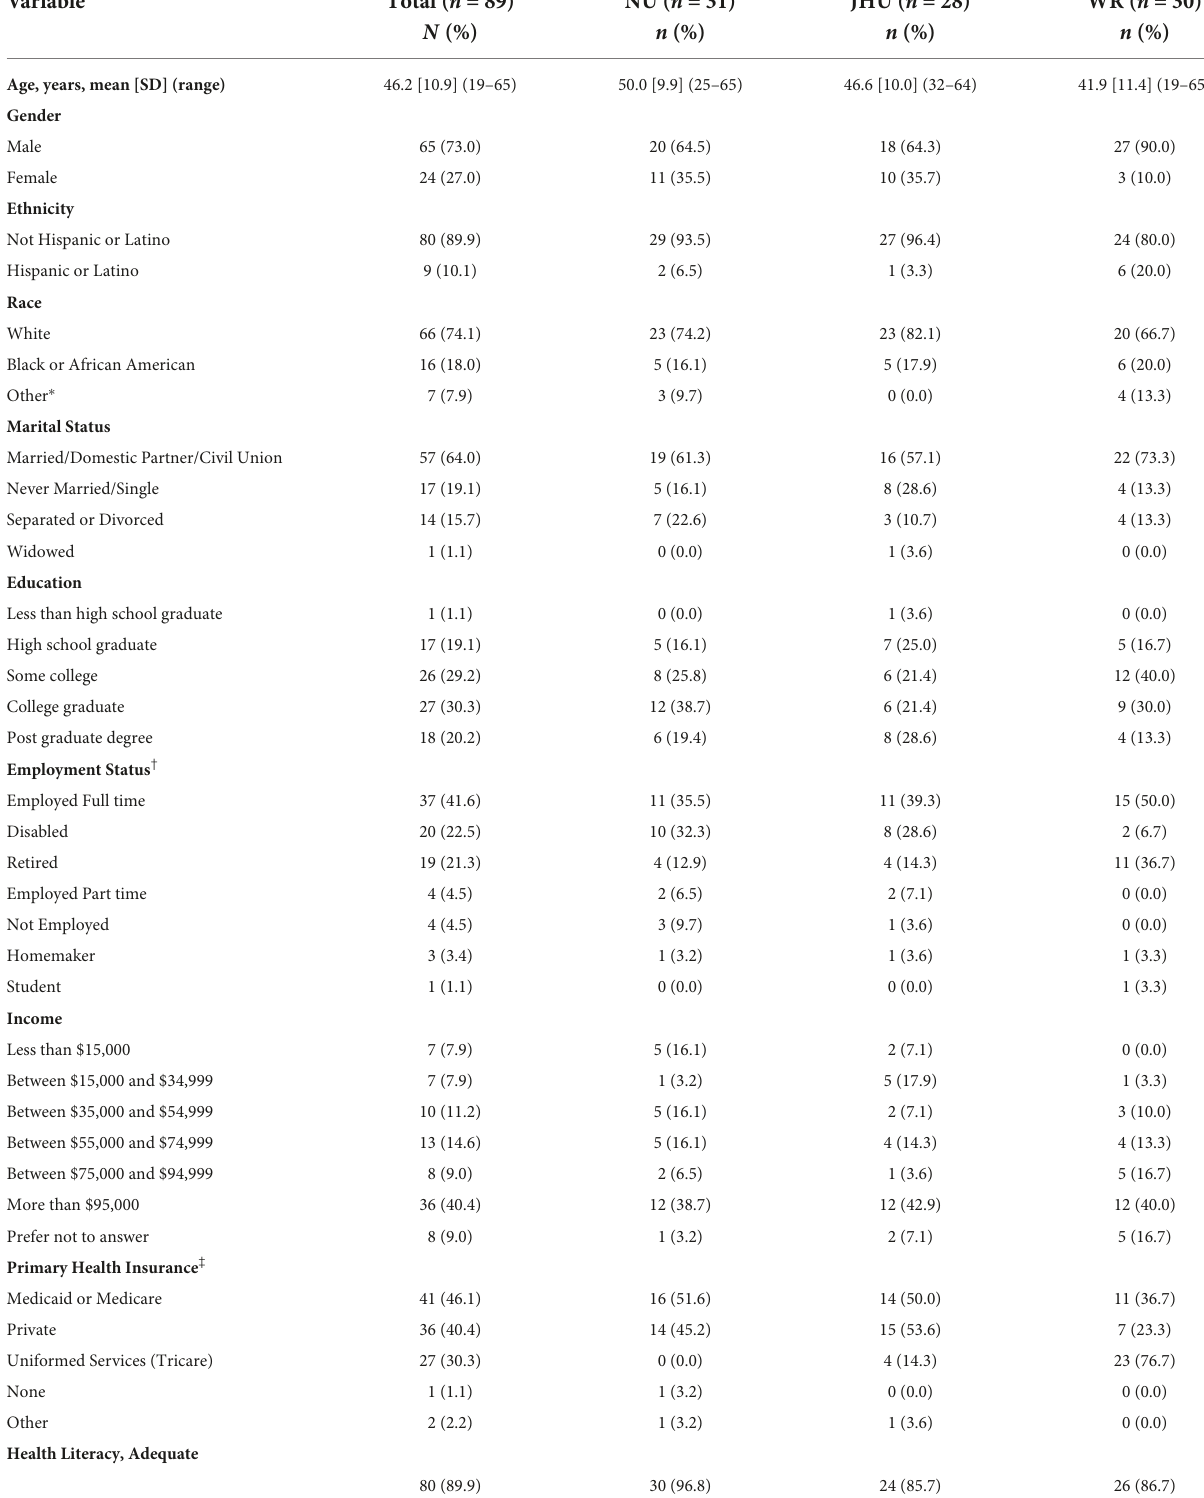
TABLE 1 Participants’ demographic and clinical